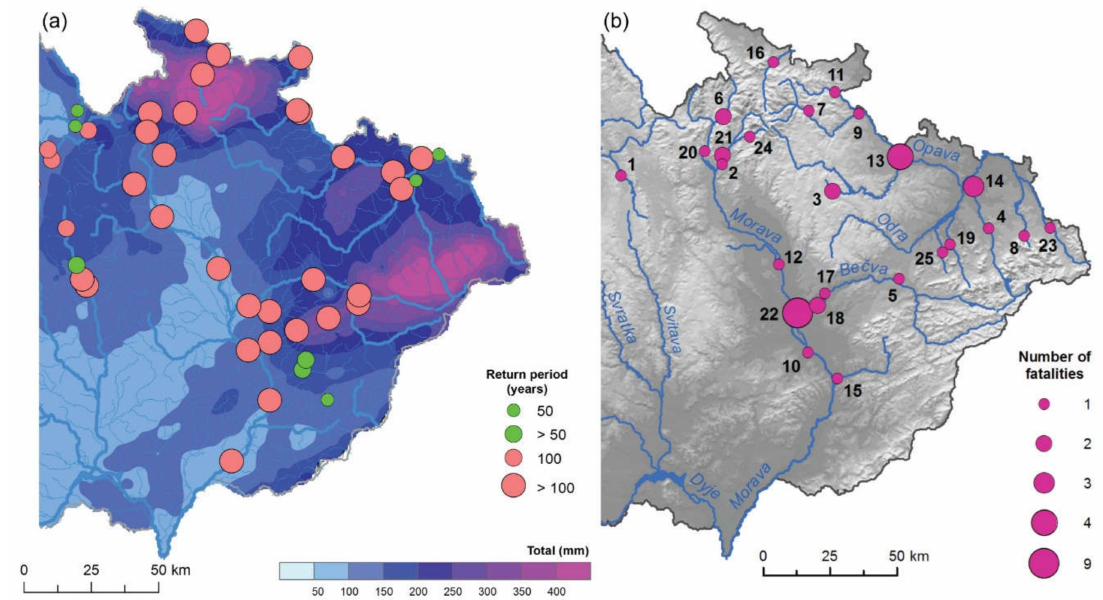
Figure 11. ( a ) Spatial distribution of precipitation totals on 5–8 July 1997 in the eastern Czech Republic and N-year return period of peak discharges Q N ≥ 50 years for Czech Hydrometeorological Institute hydrological stations; ( b ) location of places with documented numbers of fatalities during the